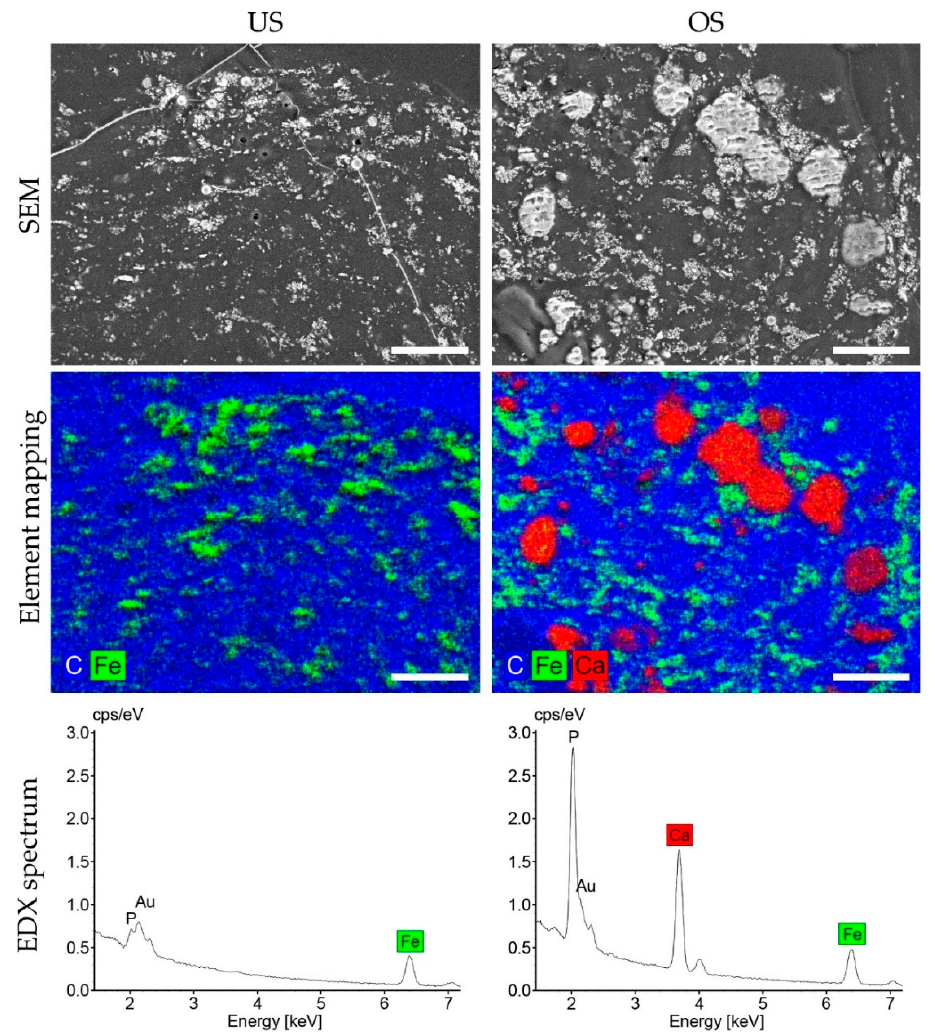
Figure 6. SEM-EDX analyses of unstimulated and osteogenically stimulated adMSC in 3D spheroid culture after 14 days. The surface planes exposed after cutting for histological analysis from the embedded unstimulated spheroids (US) or osteogenic-stimulated spheroids (OS) were investigated with a secondary electron detector. This reveals metal particles and deposited calcified matrix as brighter areas within the spheroids ( top panel). Combined mapping with X-ray spectroscopy shows the specific element distribution across the samples. Iron particles (green) and calcium-containing deposits (red) are located in a carbon-rich matrix of cells and resin (blue), as outlined by the corresponding color coding ( middle panel). Spectra recorded from the area during mapping (acquisition time: 6 min) show characteristic element peaks for calcium and phosphorus only in the osteogenically stimulated spheroids, in line with the observation that unstimulated spheroids lack calcium phosphate matrix deposition ( bottom panel). Similar amounts of iron, i.e., traces of the magnetic nanobeads used for spheroid generation, are found in the spectra of both samples (scale bars: 30 µm).